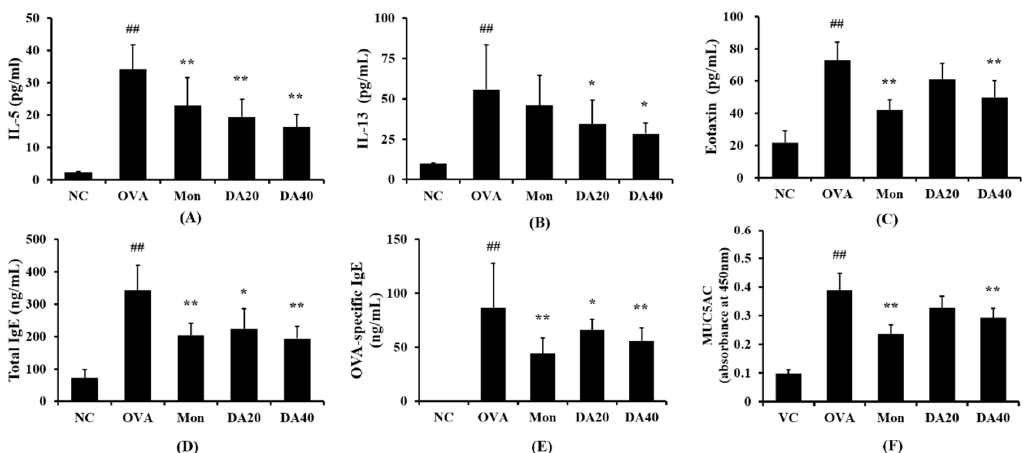
Figure 5. DA decreased the level of Th2 cytokines and IgE in OVA-induced asthma model. ( A ) IL-5, ( B ) IL-13, ( C ) Eotaxin, ( D ) Total IgE, ( E ) OVA-specific IgE, and ( F ) MUC5AC. NC: normal controls,